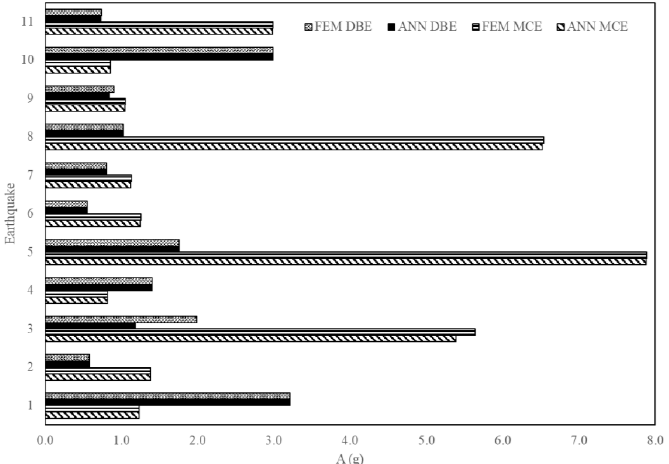
Figure 17. Base shear of a three-story mass irregularity structure obtained from ANN and NLTHA considering DBE and MCE levels.